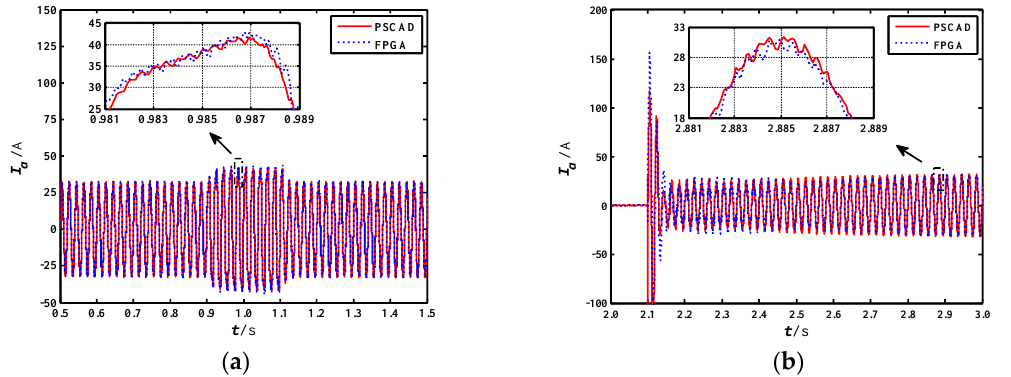
Figure 9. Test cases of the active distribution networks. ( a ) Scenario 1: The PV connected with the infinite bus system. ( b ). Scenario 2: The active distribution network with a PV.